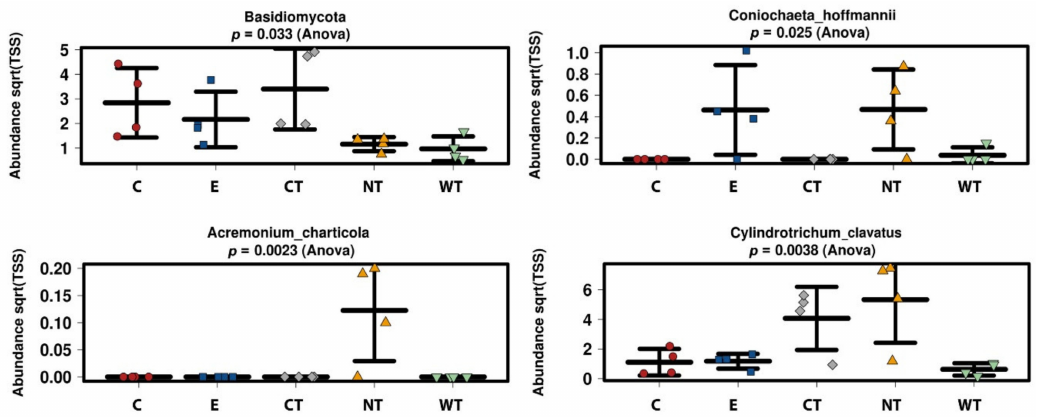
Figure 6. Boxplots showing the relative abundance of selected fungal taxa identified as biomarkers in the LEfSe analysis. (C: cinnamon; E: ethanol; CT: common thyme; NT: not-treated control; WT: wild thyme).